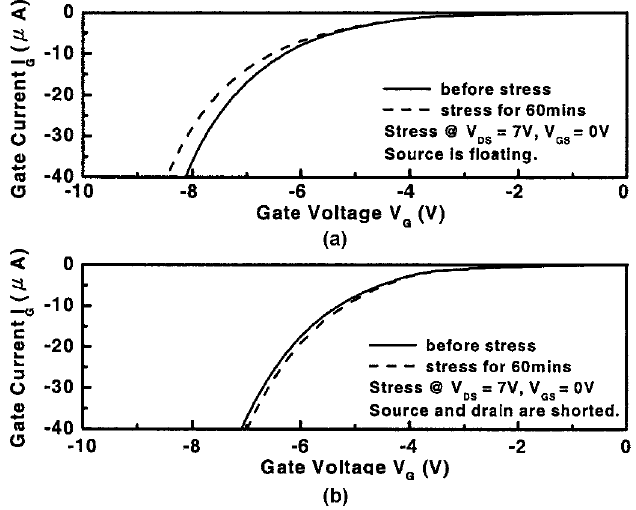
FIGURE 7 The reverse bias characteristics of the gate-drain diode of InGaP PHEMTs. (a) The source is floating. (b) The source and drain are